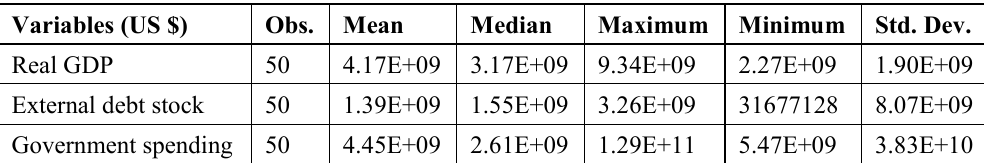
Table 1. Descriptive Statistics of Research